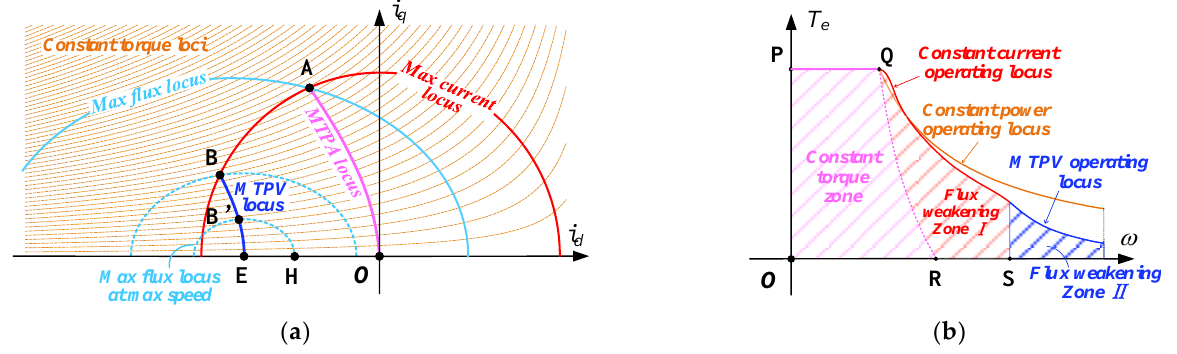
Figure 3. Mapping of d-q current to external characteristic region of torque when feature points are in current circle: ( a ) d-q axis current plane; ( b ) torque-speed plane.